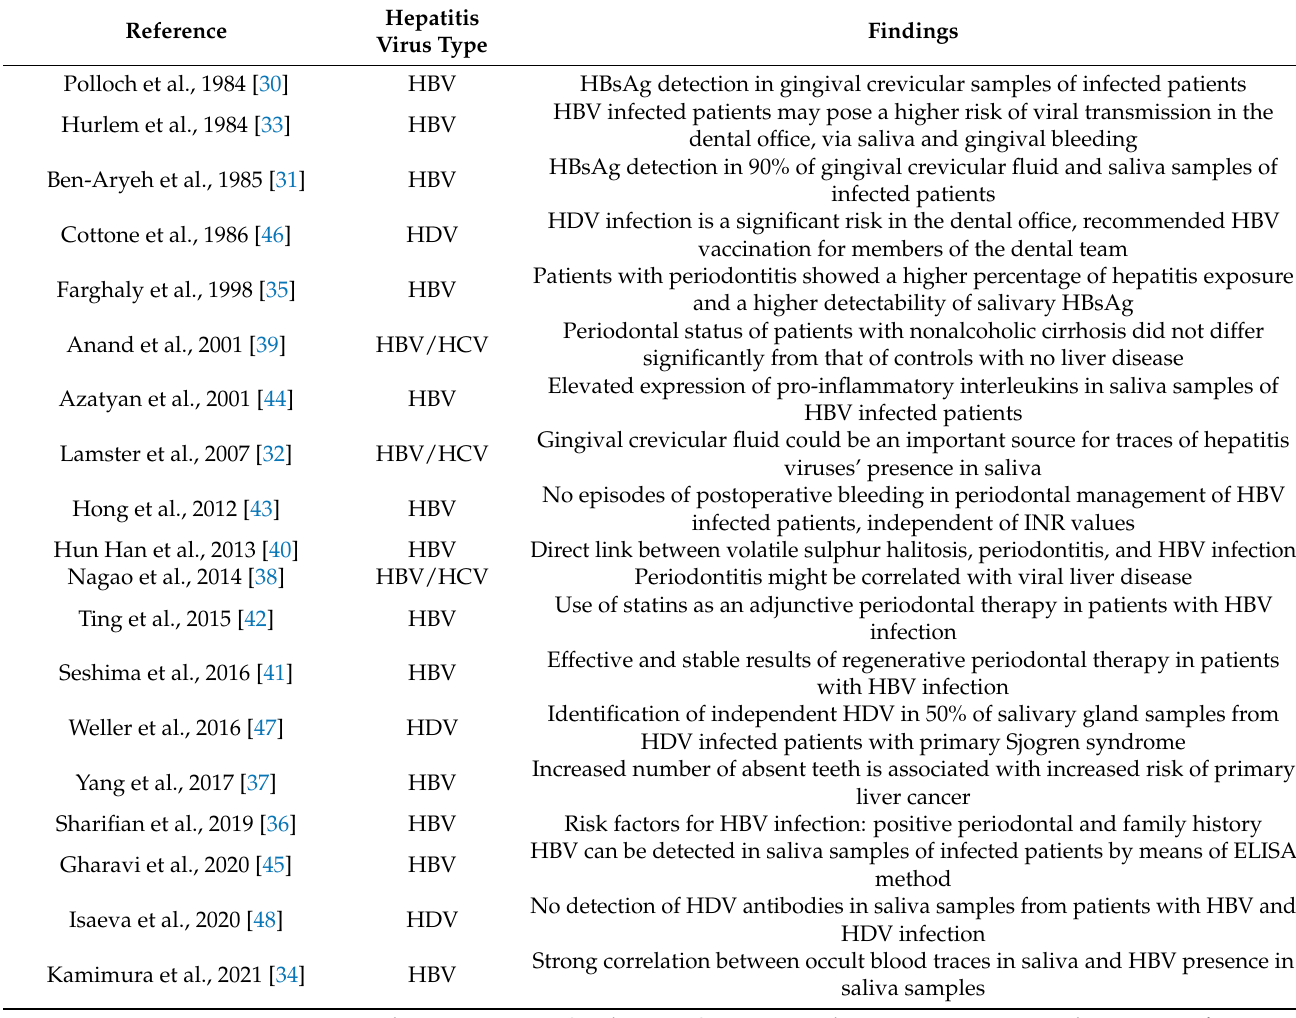
Table 1. Synopsis of the selected papers and their